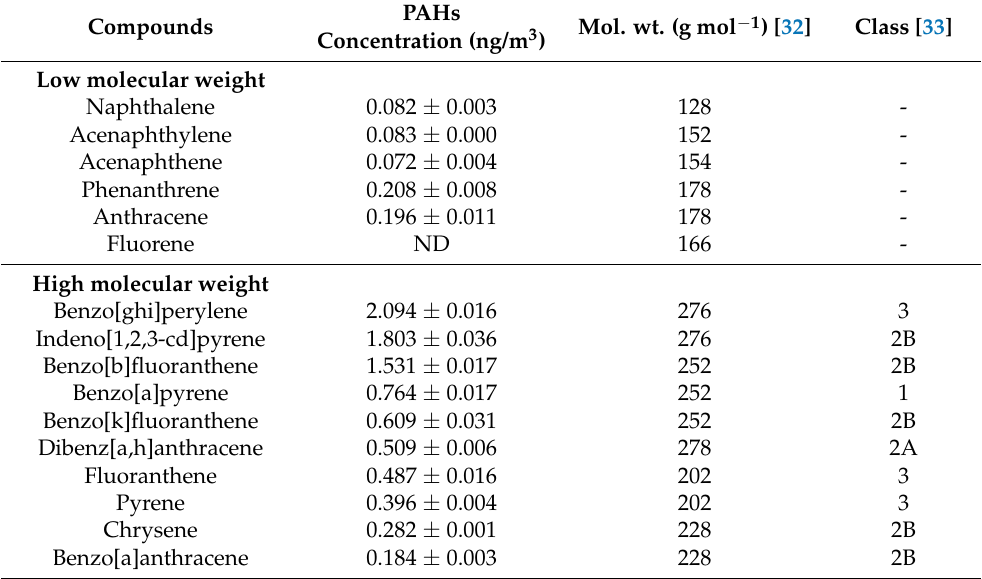
Table 2. The PAHs compounds of PMFF analyzed by